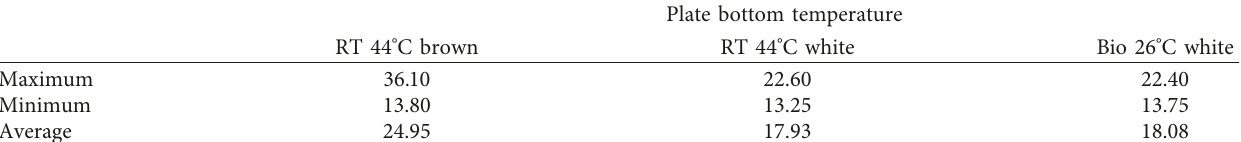
Table 12: Plate bottom temperature measurements of Test 2 ( ° C).